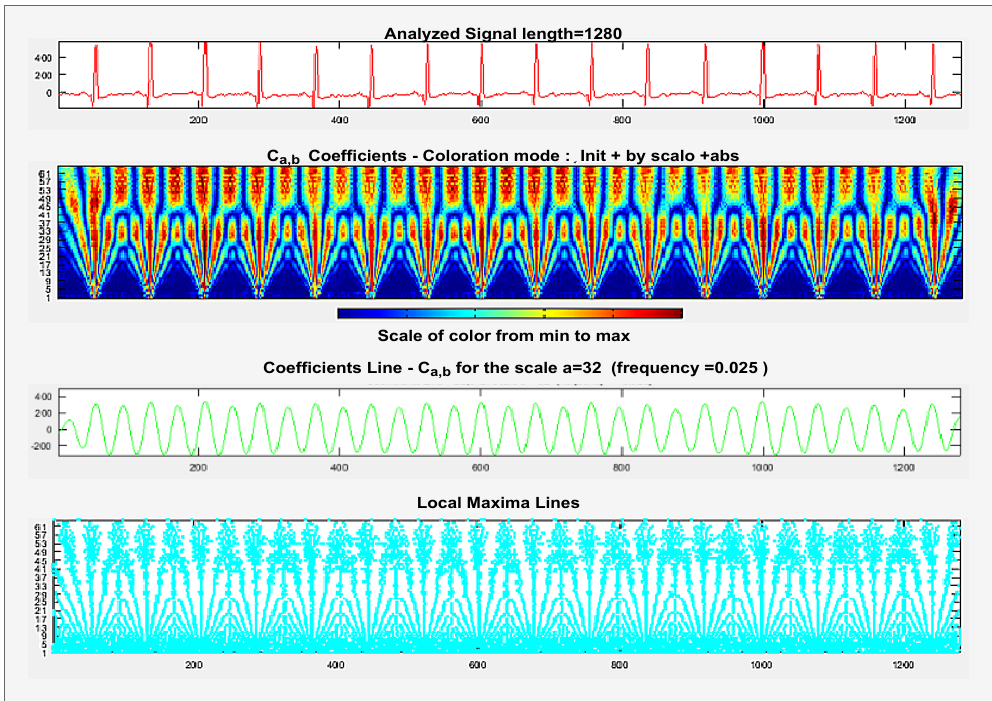
Figure 4. Different coefficient representation of